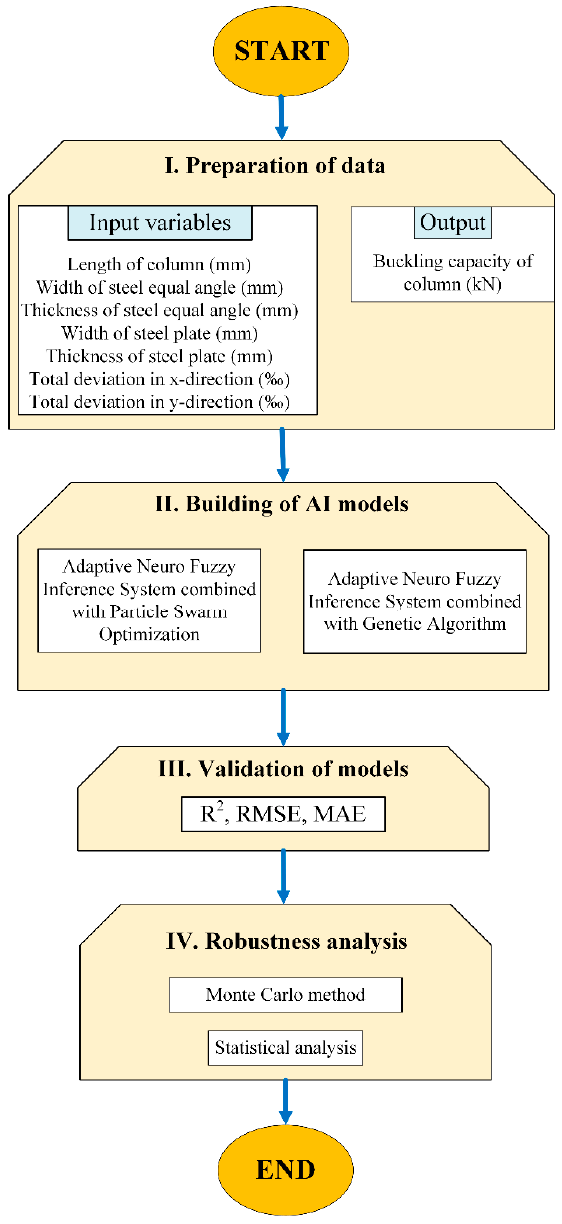
Figure 6. Methodology flow chart of this study.